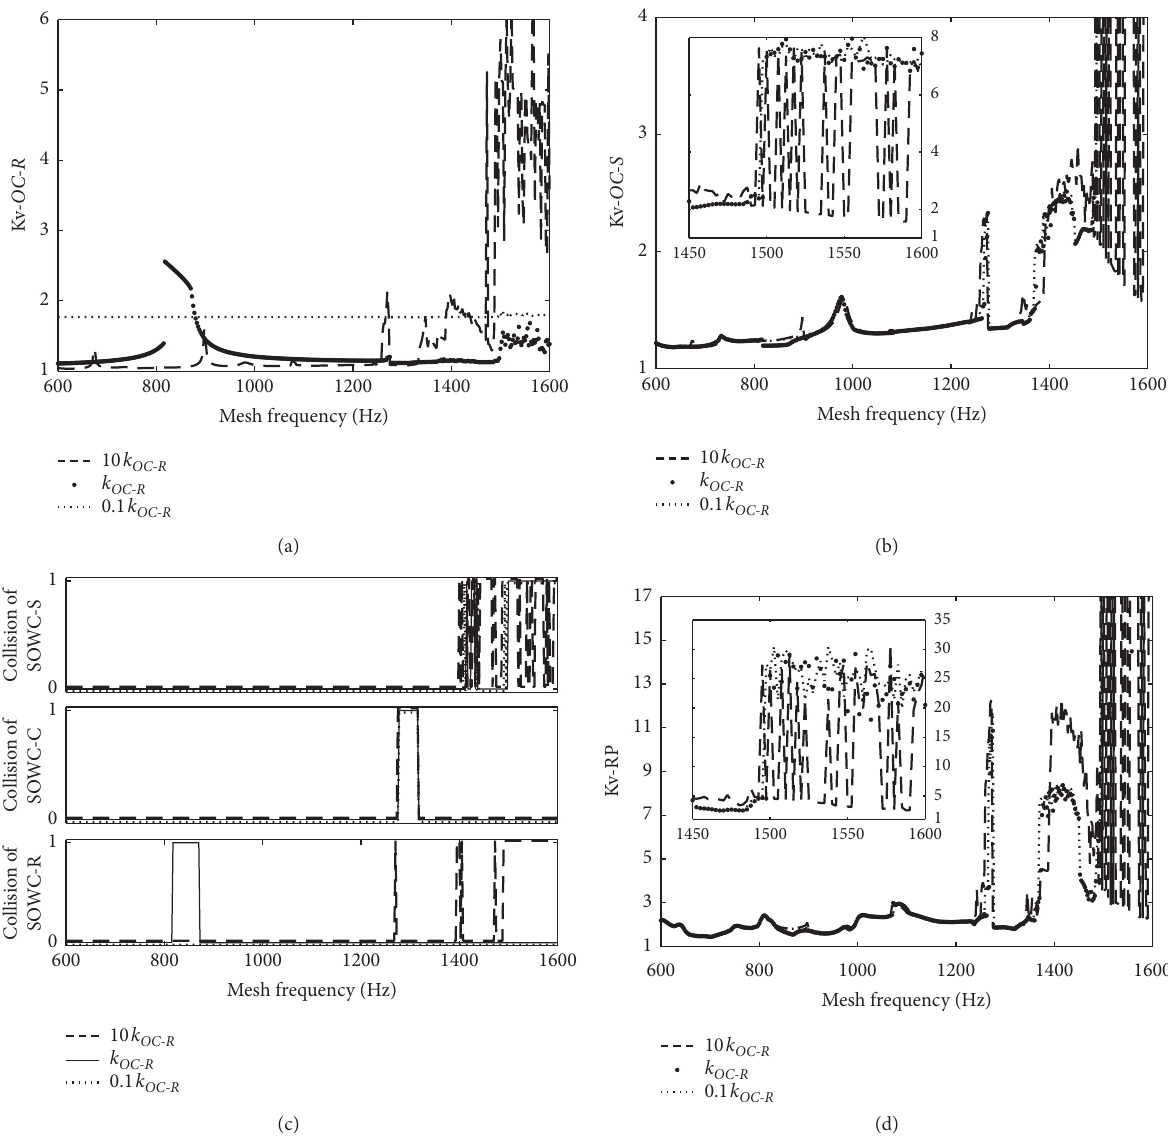
Figure 11: Nonlinear dynamics of the unit as stiffness of SOWC-R changed. (a) Load characteristics of SOWC-R. (b) Load characteristics of SOWC-S. (c) Collision of each SOWC. (d) Load characteristics of